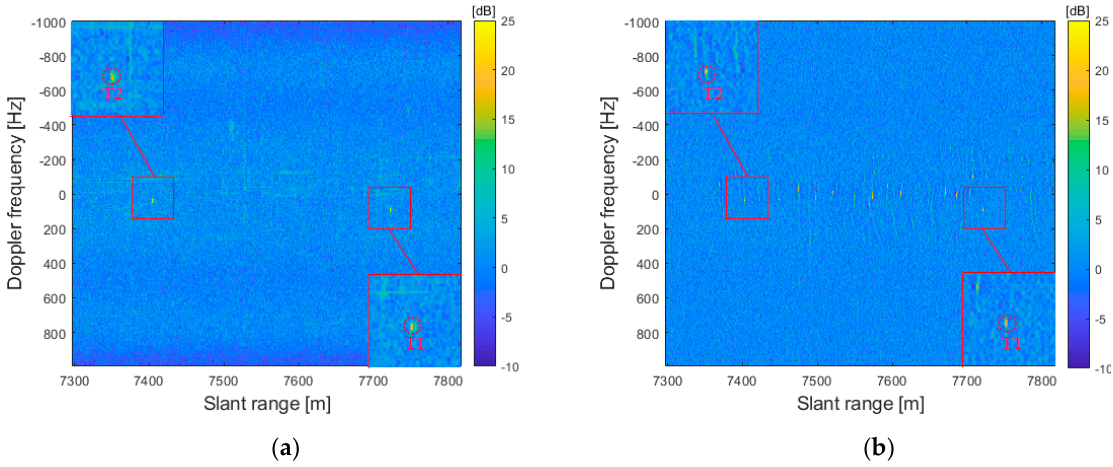
Figure 8. Range − Doppler images: ( a ) the proposed method; ( b ) PD − STAP.